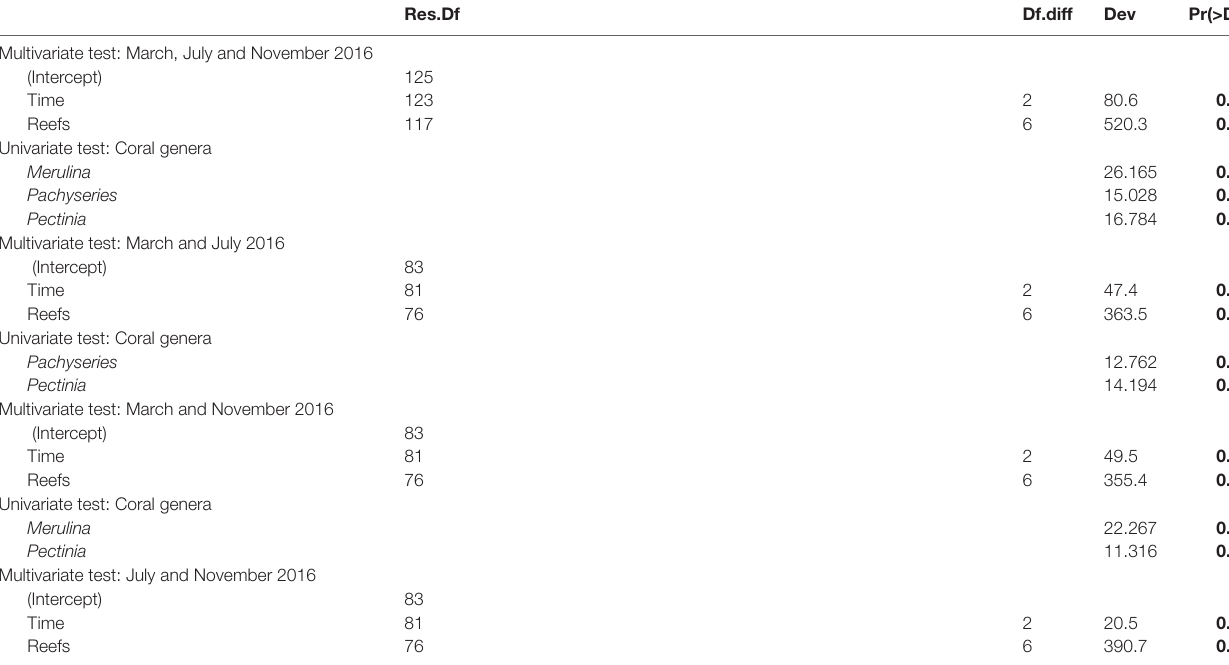
TABLE 2 | Summary statistics for analysis of coral community composition pooled among reefs across months (March, July and November 2016).